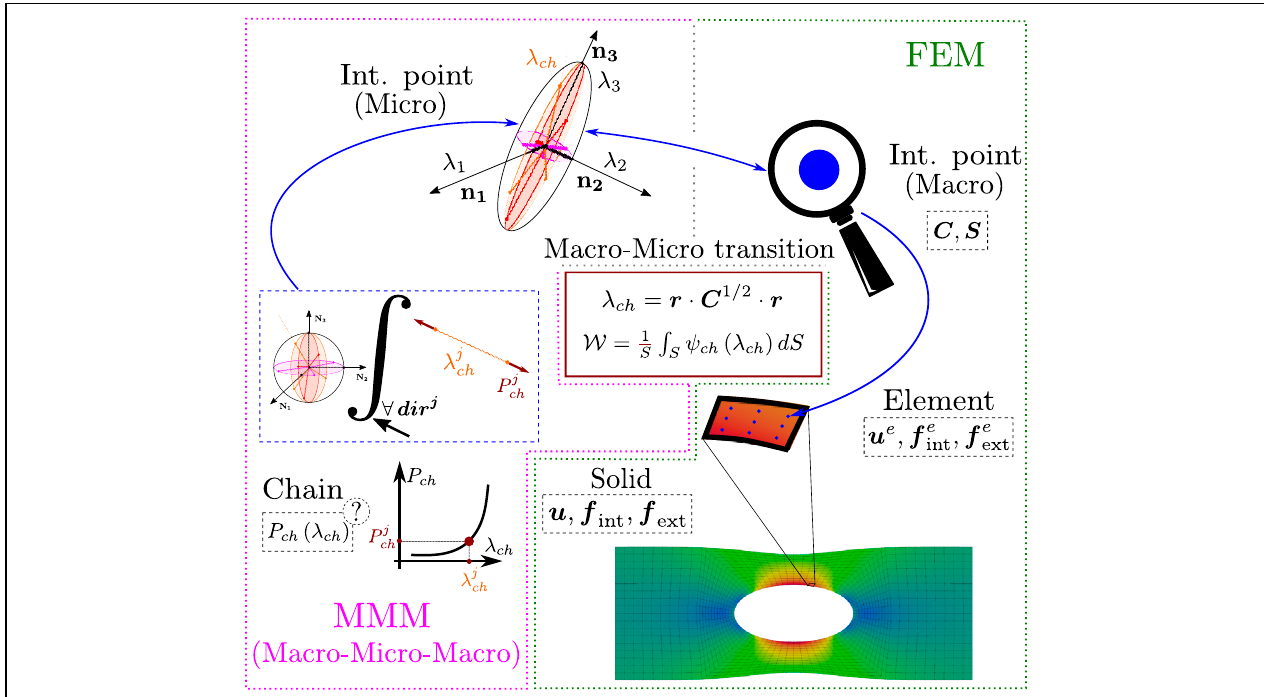
FIGURE 1 | On the right side the FEM part (green contour), from bottom to top there are different levels, first at the solid level, the nodal displacement vector, u , the nodal internal forces, f int , and the external nodal forces, f ext , are encountered. Second, at the element level, the elemental nodal displacement vector, u e , the elemental nodal internal forces, f e int , and the elemental external nodal forces, f e ext . Finally, the integration point (at the macro-scale) characterized by the Right Green Cauchy tensor C , and the PK2 stress tensor, S , at this point. On the left hand side the Macro-Micro-Macro approach (magenta contour), the general idea would be “zooming” (hence the magnifying glass) on the integration point and consider that for polymeric materials, the chains oriented in a certain direction (representative direction) suffer a deformation described by the continuum stretches ellipsoid (upper left). The a priori unknown chain mechanical behavior, P ch ( λ ch ) (bottom left), will be evaluated for each direction and the effect in each representative direction will be integrated for all the representative directions on the reference unit micro-sphere (center left) to obtain the continuum principal stress components. Finally, the Macro-Micro transition (center of the figure) dictates how the continuum energy is obtained from the constituents free energy and how the micro-structural stretches (non-affine chain stretch) are obtained from the continuum deformation measures. From a more practical perspective: 1) The Macro-Micro-Macro approach expresses the continuum principal stresses in terms of the unknown P-Spline vertices for the constituents mechanical behavior, S ( ̂ v ) , and 2) A classical FEM assembly process is employed to write nodal equilibrium equations from the information at the integration points, F int ⋅ ̂ v = f ext . The substeps involved are: 1.1) The continuum strain, C , tensor defines the micro-structural deformations, λ ch on the representative directions; 1.2) The micro-mechanical behavior (unknown a priori ) is evaluated in all the representative directions in terms of the unknown vertices ̂ v , P ch ( λ ch ) = B row ( x )⋅ ̂ v ; 1.3) The constituents mechanical behavior in all directions is integrated over the unit micro-sphere to obtain the continuum principal stresses at the integration point, S ( ̂ v ) ; 2.1) The integration point stress S ( ̂ v ) is integrated over the element volume to obtain the elemental nodal internal forces, f e int ( ̂ v ) ; 2.2) The elemental nodal internal forces are assembled to obtain the nodal internal forces of the solid, f int ( ̂ v ) ; 2.3) The unknown vertices are determined from equilibrium, f int ( ̂ v ) = F int ⋅ ̂ v = f ext